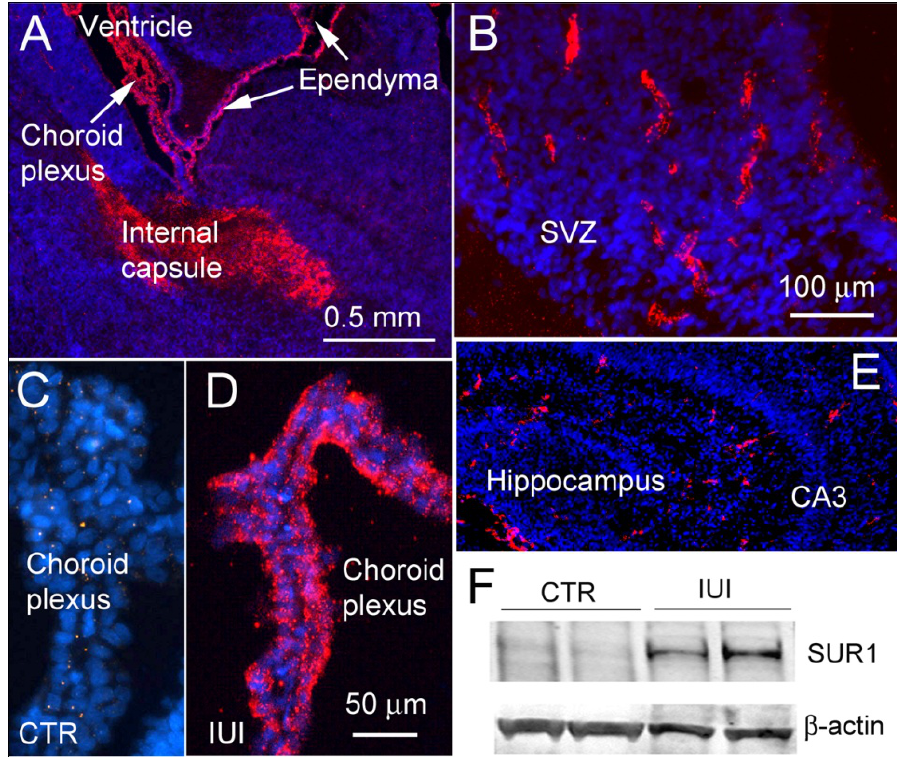
Figure 1. Sulfonylurea receptor 1 (Sur1) is upregulated following 20 min of intrauterine ischemia (IUI). ( A – E ): coronal brain sections 24 h after 20 min of IUI ( A , B , D , E ) or from an uninjured sham control ( C ) immunolabeled for Sur1, showing prominent Sur1 expression in choroid plexus, ependyma and internal capsule ( A , D ), in the subventricular zone (SVZ) ( B ), and in the hippocampus ( E ) following IUI, but not in the control ( C ); the images shown are representative of data from 10 brains after IUI and 3 controls. ( F ): Immunoblots for Sur1 of periventricular tissues 24 h after 20 min of IUI or from uninjured controls (CTR), as indicated; each lane represents a different brain; β -actin used as a loading